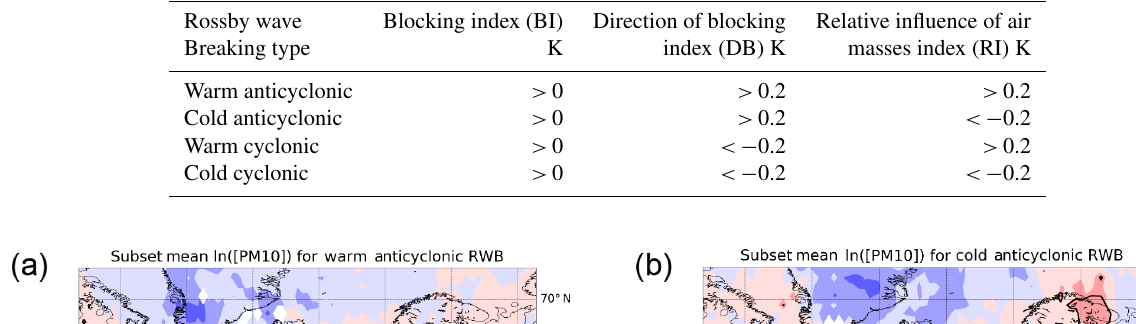
Table 1. Defining Rossby wave breaking (RWB) types using thresholds of the direction of blocking (DB) and relative influence of air masses (RI) indices. Any RWB with DB or RI values of − 0.2 ≤×≤ 0.2K is determined as unclassified following Masato et al. (2012).